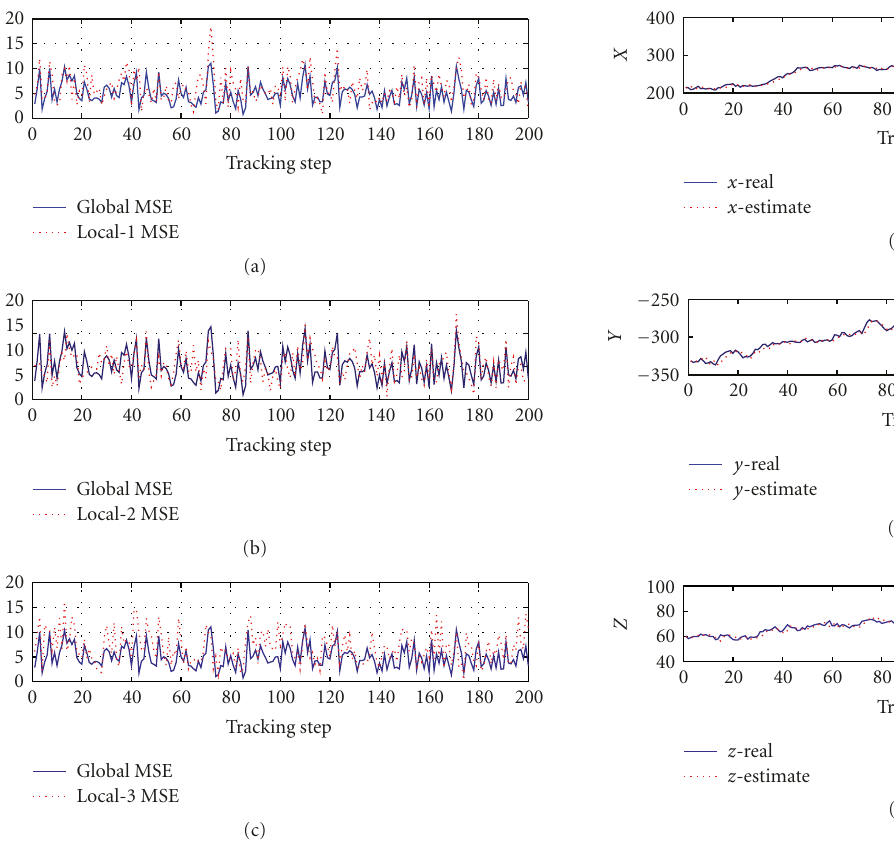
Figure 5: Simulation results of tracking.